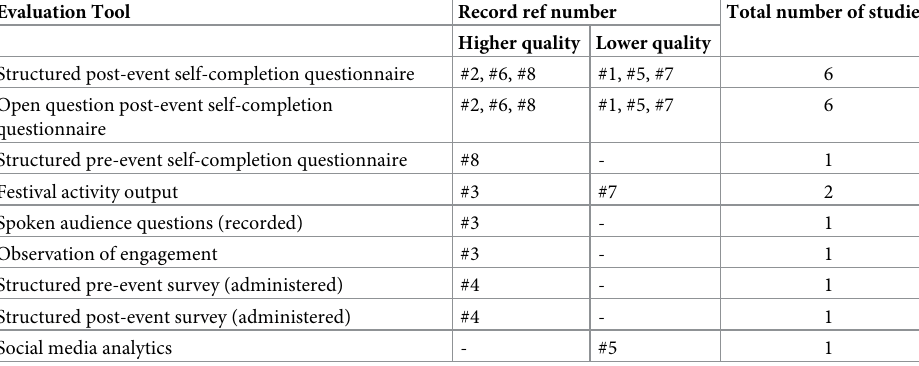
Table 2. Evaluation tools